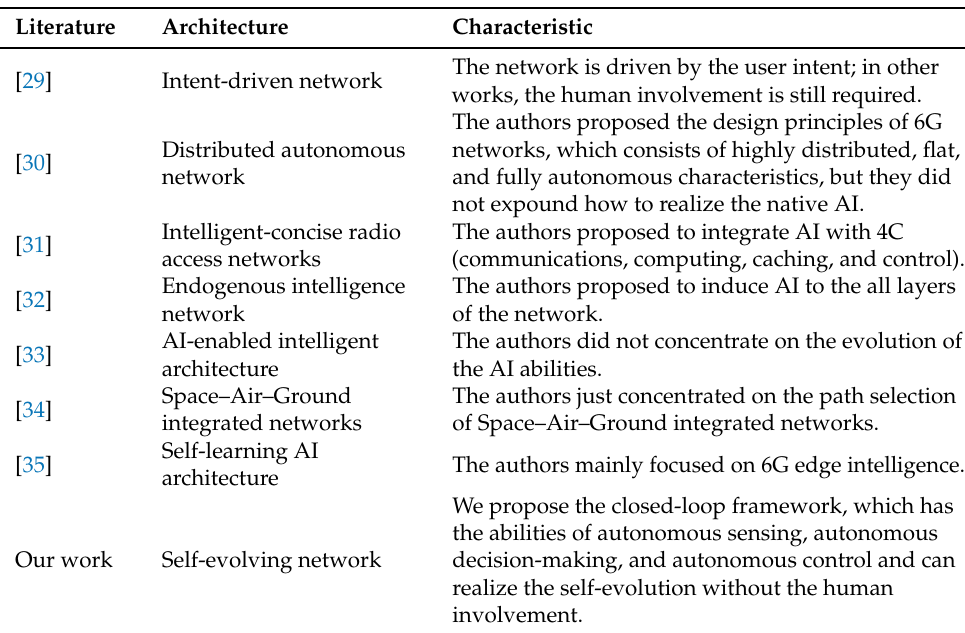
Table 3. The differences of AI among the existing intelligent networks and our proposed 6G self- evolving